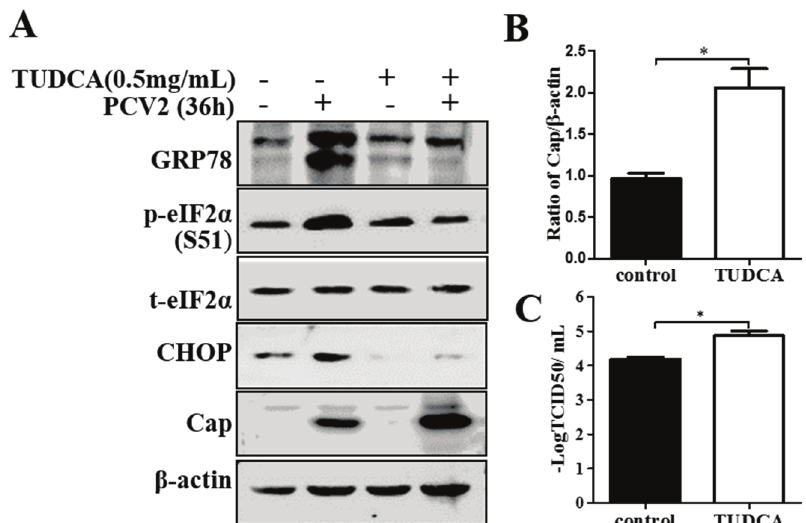
Figure 6. Tauroursodeoxycholic acid enhanced virus replication. PK-15 cells were infected with PCV2 (MOI = 1) for 36 h. Tauroursodeoxycholic acid (TUDCA) was maintained during the viral infection. Whole cell extracts were subjected to Western blotting for GRP78, phosphorylated eIF2 α (p-eIF2 α ), total eIF2 α (t-eIF2 α ), CHOP and capsid protein. ( A ) Representative blot showing the effect of TUDCA treatment on expression of target proteins; ( B ) Ratio of Cap to β -actin normalized to untreated control cells set at 1.0; ( C ) Virus titers expressed as log TCID 50 /mL.